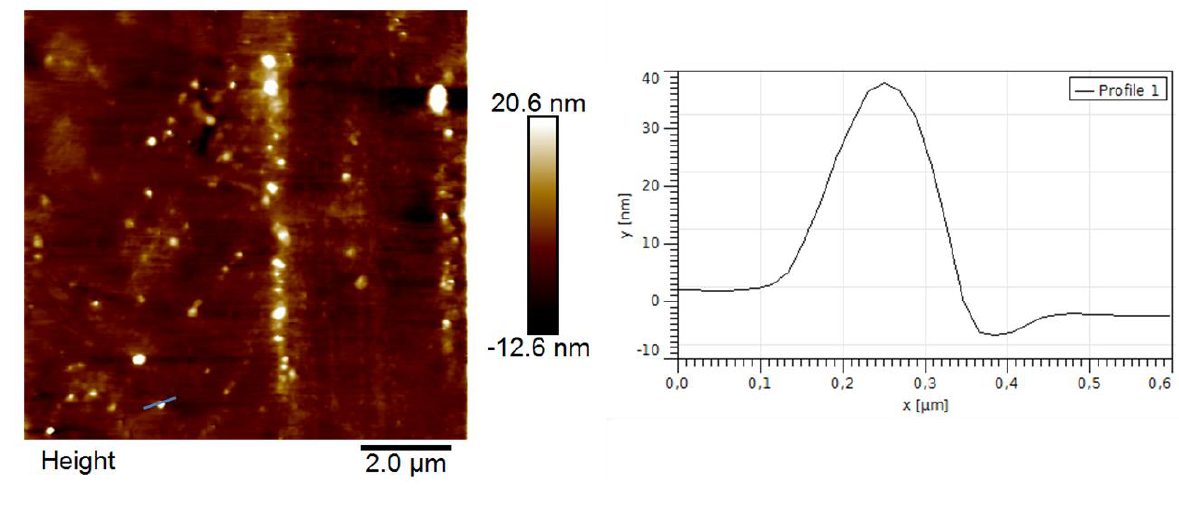
Figure 7. Atomic force microscopy image of BSA MIP